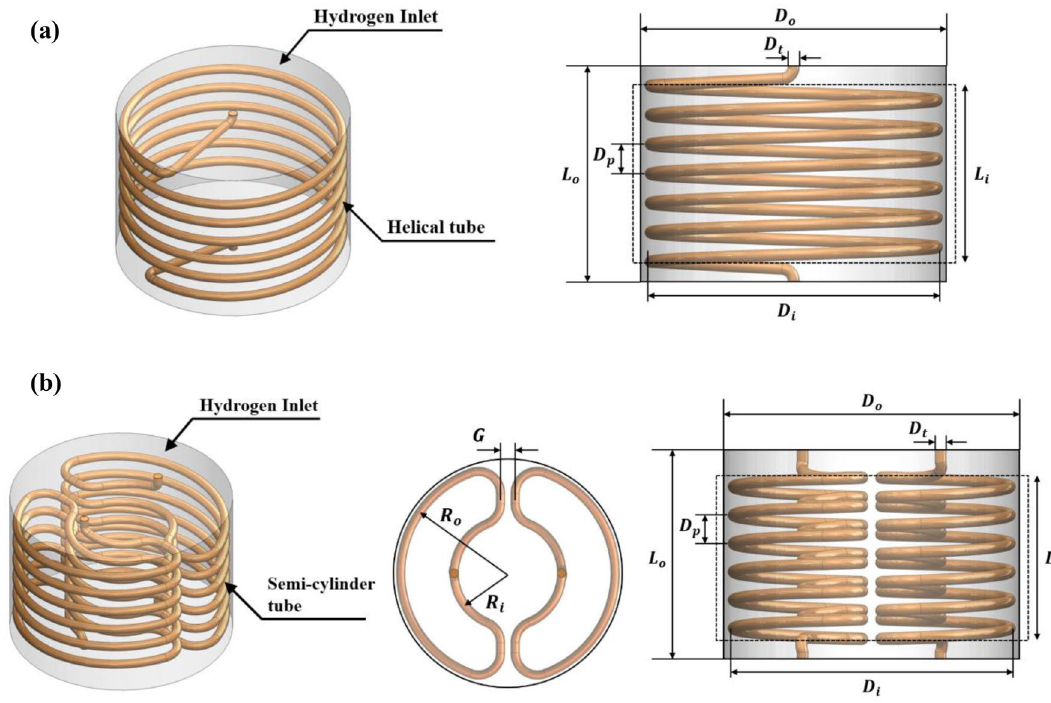
Figure 1. Characteristics of selected geometries for metal hydride reactors. ( a ) With helical tube heat exchanger, and ( b ) with semi-cylindrical tube heat